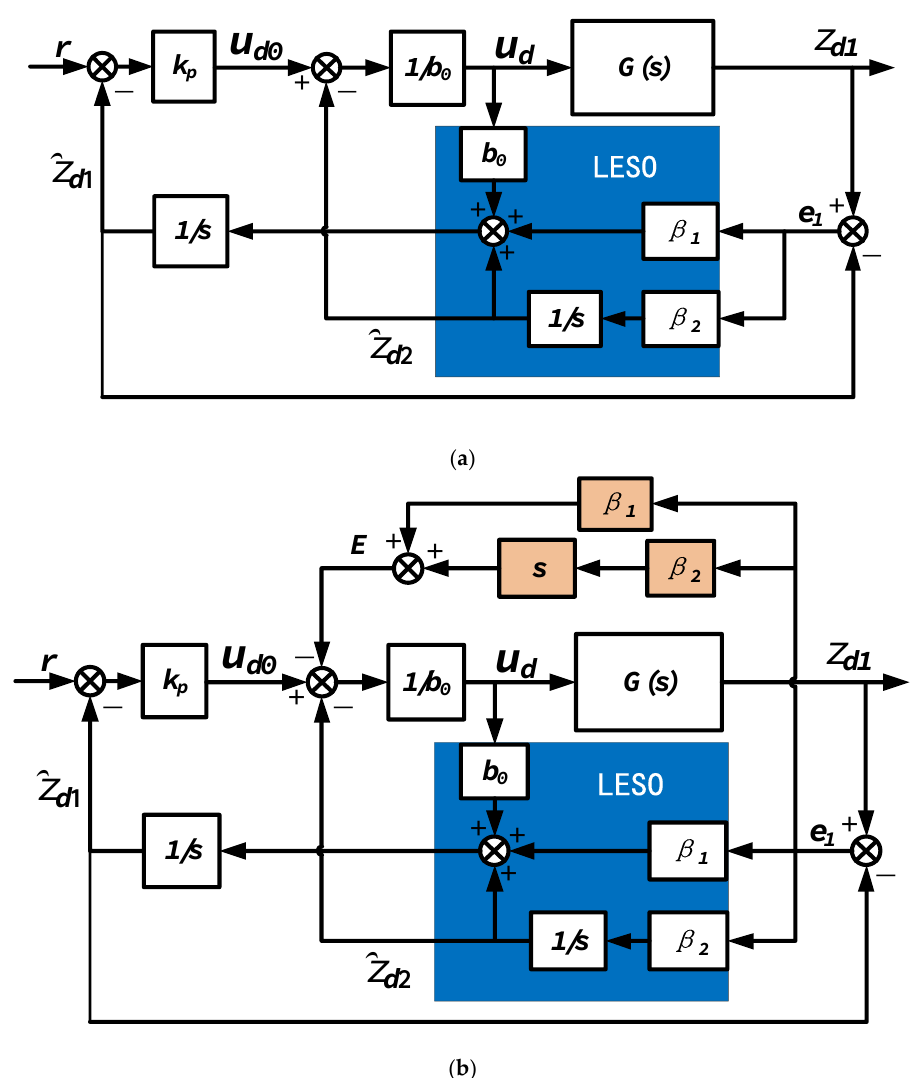
Figure 2. Comparison of traditional LADRC structure diagram and improved LADRC structure diagram. ( a ) Traditional LADRC structure diagram; ( b ) improved LADRC structure diagram.